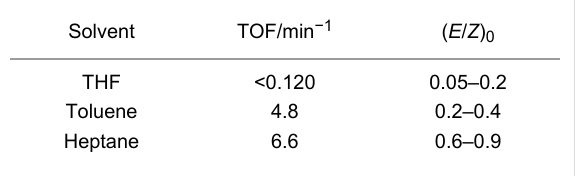
Table 2: Initial rates (TOF) and selectivity at low conversions ( E / Z ) 0 in the metathesis of methyl oleate (0.12 M) with [( ≡ SiO)(